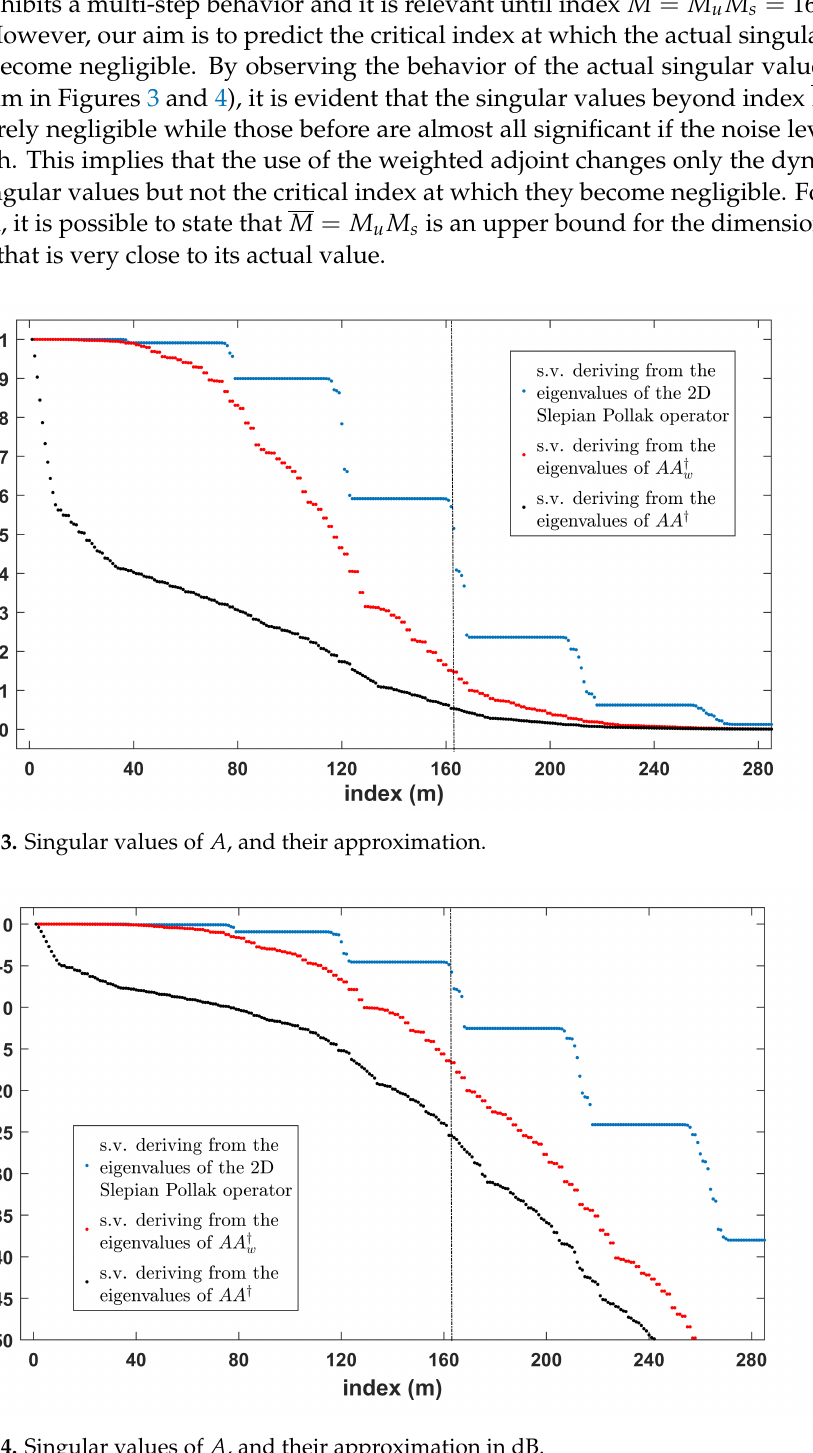
Figure 4. Singular values of A , and their approximation in